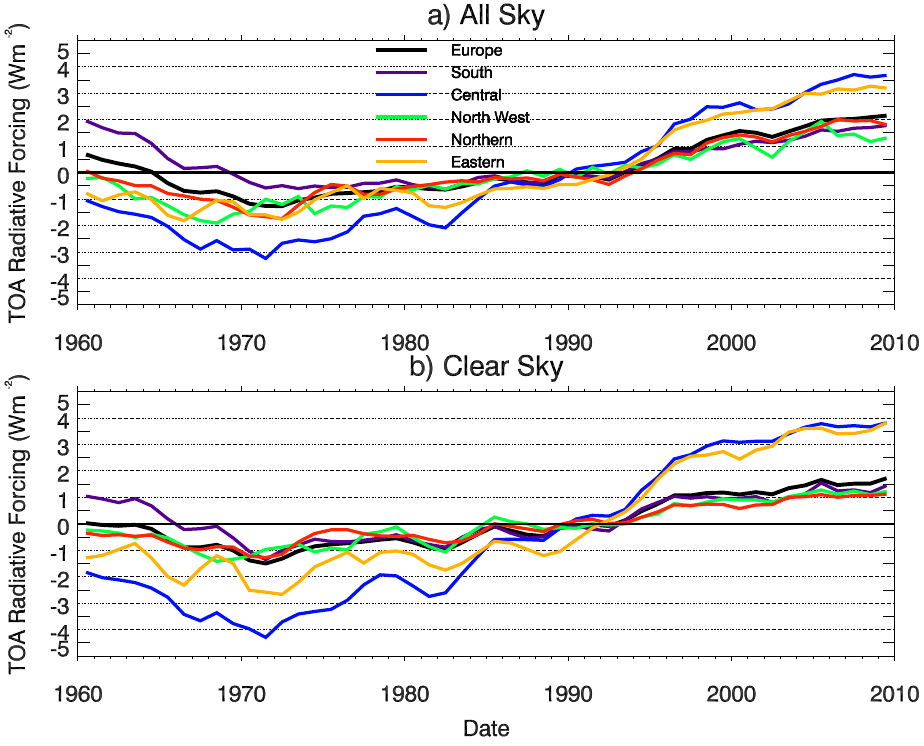
Figure 16. European and sub-regional top of atmosphere aerosol radiative forcing (Wm − 2 ), relative to a 1980–2000 average, under (a) all-sky and (b) clear-sky conditions. European regions are as defined in Fig.